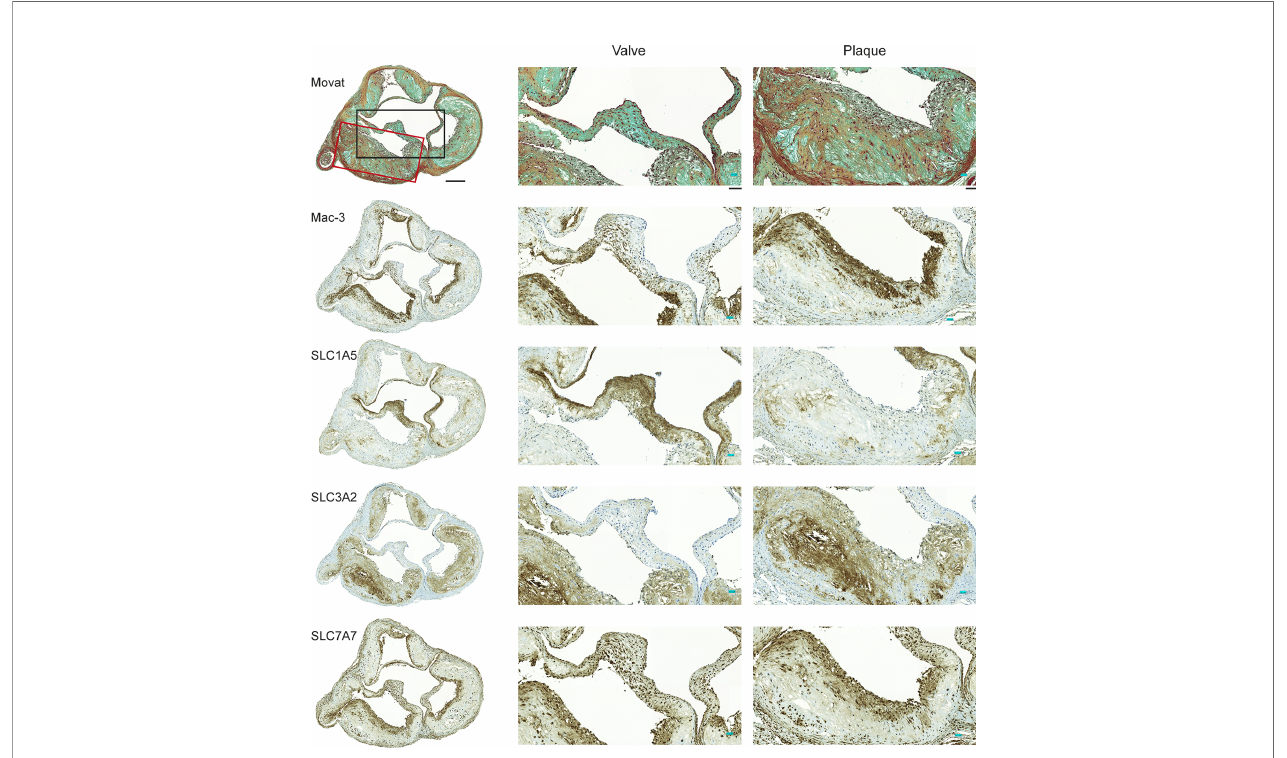
FIGURE 2 | Expression of Mac-3 and glutamine transporters by mouse aortic plaque macrophages. Movat ’ s pentachrome staining of the aortic root demonstrates that atherosclerotic plaques were composed mostly of a fi brous cap and a necrotic region. Immunostaining of adjacent sections shows that Mac-3-positive macrophages are also positive for glutamine transporters SLC1A5, SLC3A2, and SLC7A7. Higher magni fi cations of the valve and plaque vessel regions are shown in the black and red rectangular boxes, respectively. Expression of SLC1A5 is prominent in the aortic valve region but not in the vessel plaque region. Expression of SLC3A2 is absent from the valve region but present in the vessel plaque region. Expression of SLC7A7 is clear in both the valve and vessel plaque regions. Scale bar = 200 m m; zoomed region scale bar = 50 m